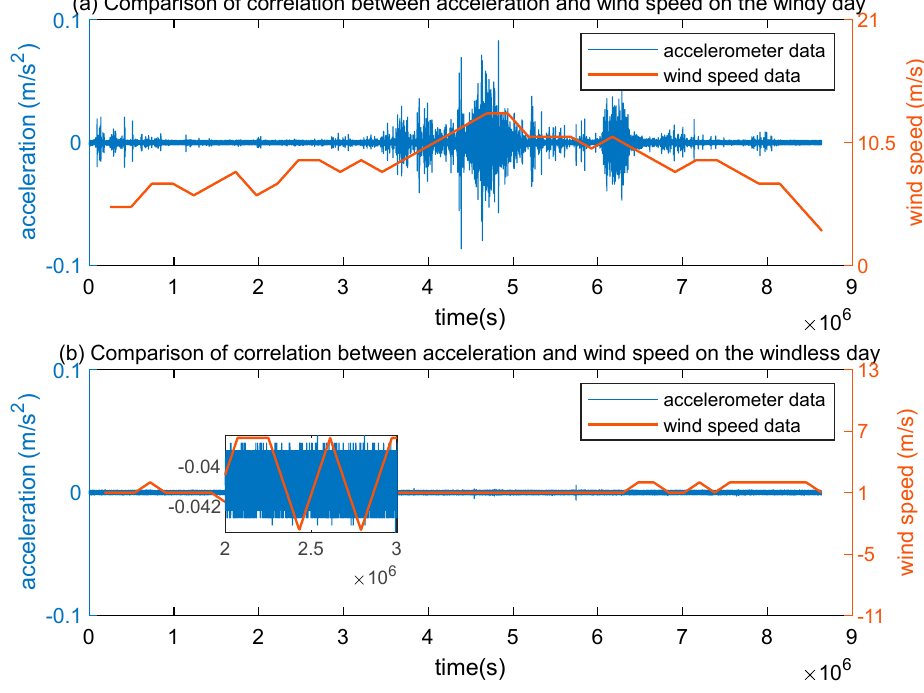
Figure 7. Comparison of the correlation between acceleration and wind speed data on breeze day.